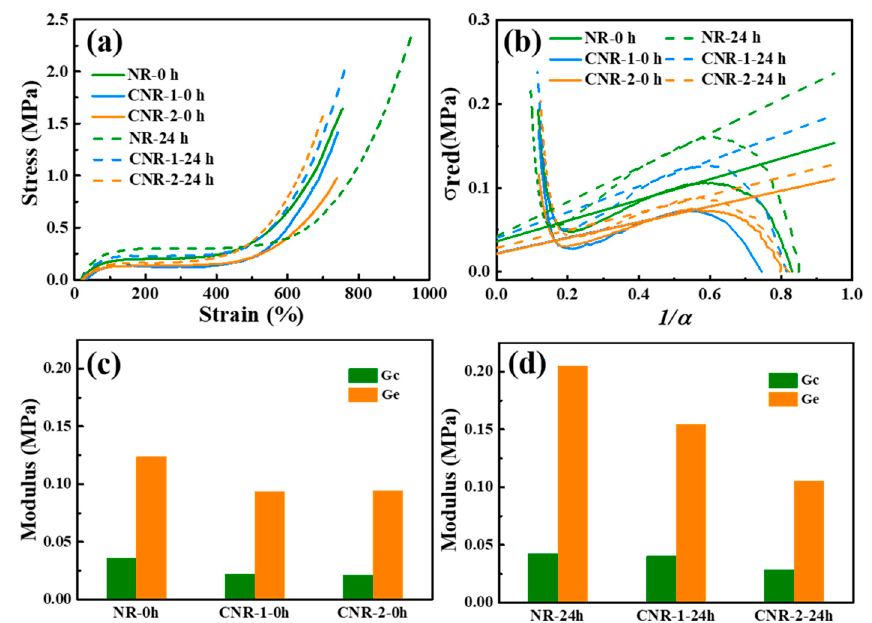
Figure 10. Stress-strain curves ( a ), Mooney-Rivlin plots of reduced stress ( b ) and parameters G c and G e ( c) ,( d ) of NR, CNR-1 and CNR-2 before and after accelerated storage.